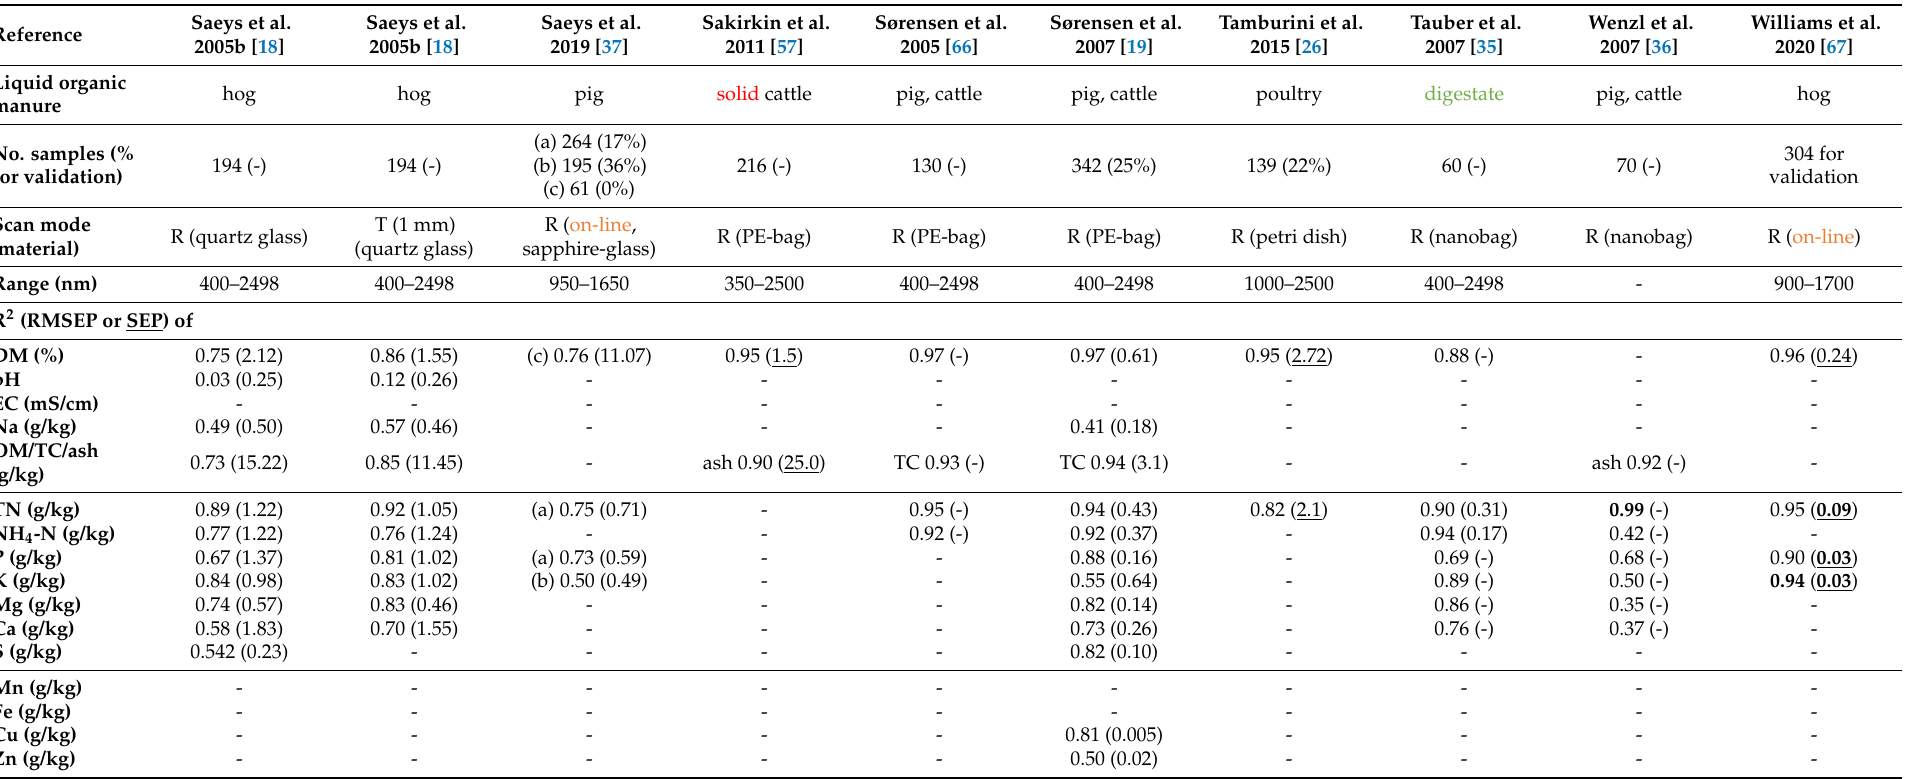
Best values for each parameter are highlighted in bold letters, dried samples in red, digestate samples in green, on-line technique in orange, and SEP values in underlined letters. Scan mode: R = reflectance, T = transflectance; Parameters: DM = dry matter, EC = electrical conductivity, OM = organic matter, TC = total carbon, TN= total nitrogen, TDN = total dissolved nitrogen; R 2 = coefficient of determination, RMSEP = root mean squared error of prediction, SEP = standard error of